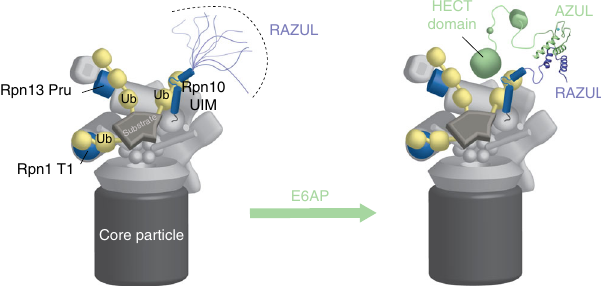
Fig. 7 Model of hRpn10 RAZUL recruitment of E6AP to the 26S proteasome. Proteasome substrate receptors Rpn1, Rpn10, and Rpn13 recognize ubiquitin chains (yellow) through their T1 site (blue), UIM region (blue), and Pru domain (blue), respectively. The Rpn10 C-terminal RAZUL is intrinsically disordered (left panel), but folds to form a 4-helix bundle with the AZUL domain of E3 ligase E6AP (green), thus recruiting E6AP to the proteasome (right panel). Zn, light